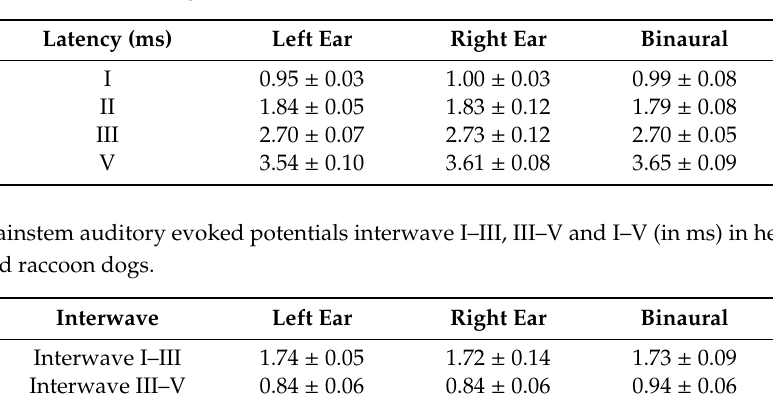
Table 1. Brainstem auditory evoked potentials latencies for waves I, II, III and V (in ms) in healthy adult anesthetized raccoon dogs.